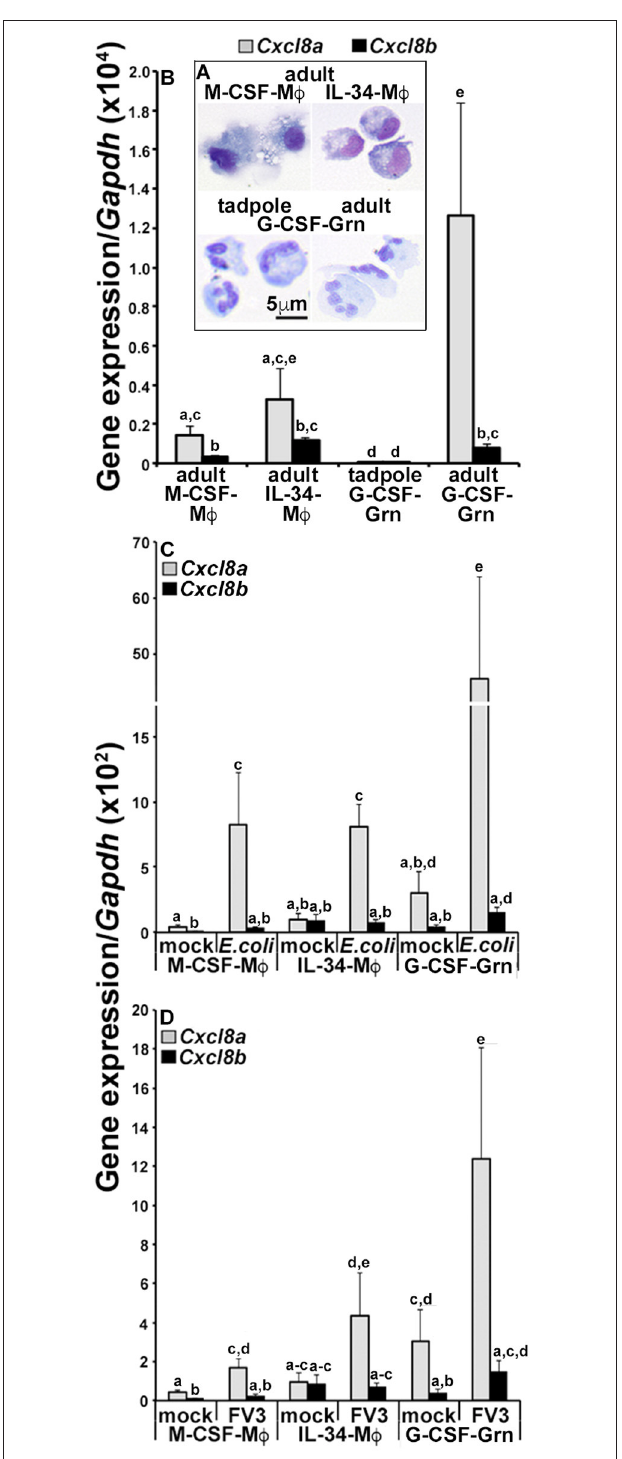
FIGURE 3 | Analyses of CXCL8a and CXCL8b gene expression in frog macrophages and granulocytes . (A) Cytology of tadpole rG-CSF-elicited peritoneal granulocytes (G-CSF-Grn) and adult frog bone marrow-derived macrophages, differentiated with rM-CSF (M-CSF-M φ ) or rIL-34-M φ s (L-34-M φ ) and granulocytes (Grn), differentiated with rG-CSF (G-CSF-Grn).